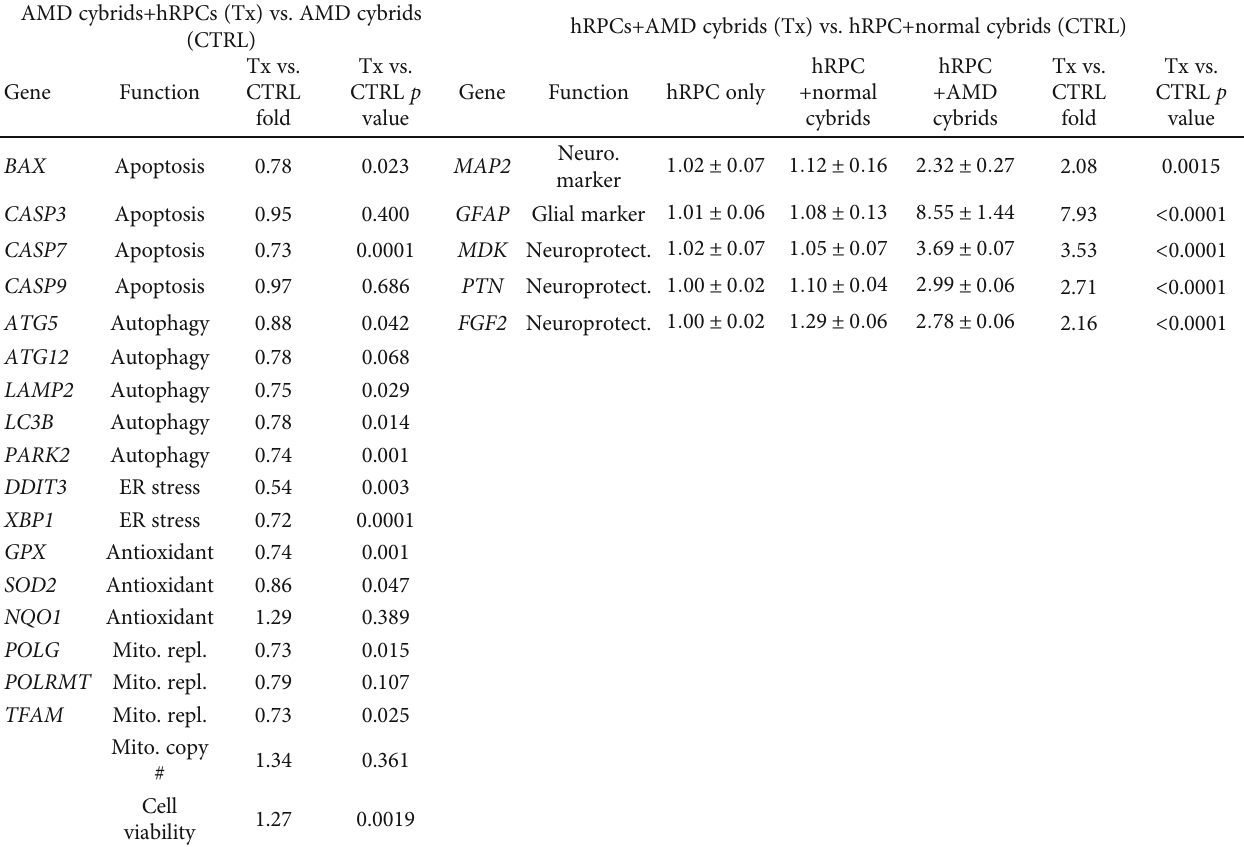
Table 3: qRT-PCR analysis for di ff erential gene expression, mitochondrial copy number, and cellular viability for AMD/hRPC vs. AMD and hRPC/AMD vs. hRPC/normal cybrids.